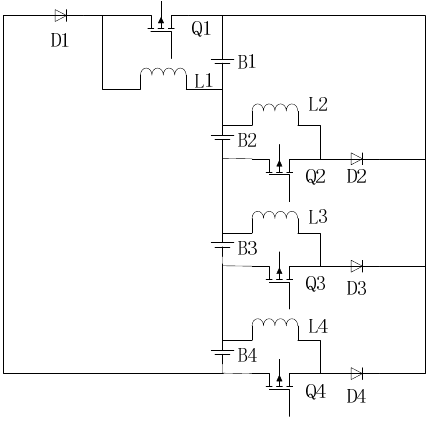
Figure 2. Battery string with DC-DC converter equalizer.